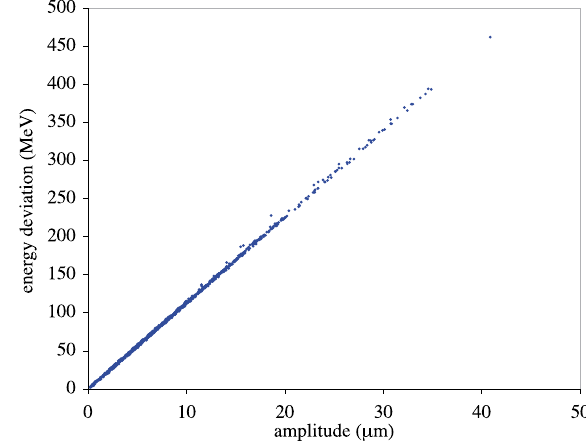
cavity condi- 210